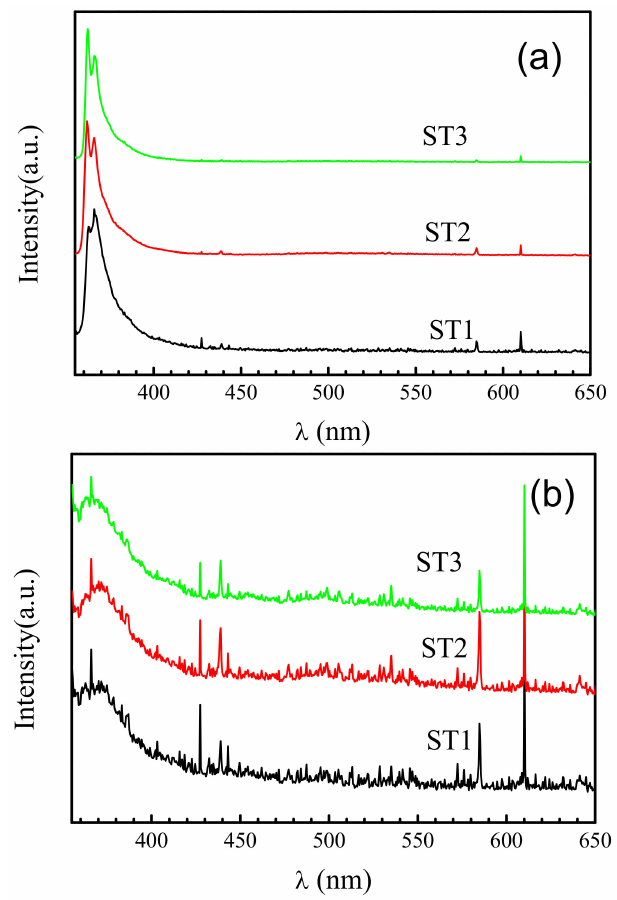
Figure 3. Photoluminescence spectra of samples ST1, ST2, and ST3 measured at ( a ) 10 K and ( b ) room